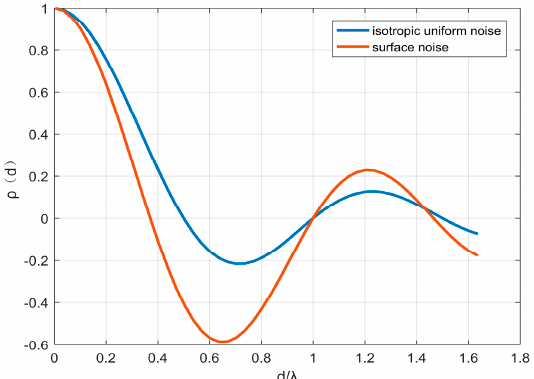
Figure 1. Vertical correlation coefficients in the isotropic noise field and surface noise field.